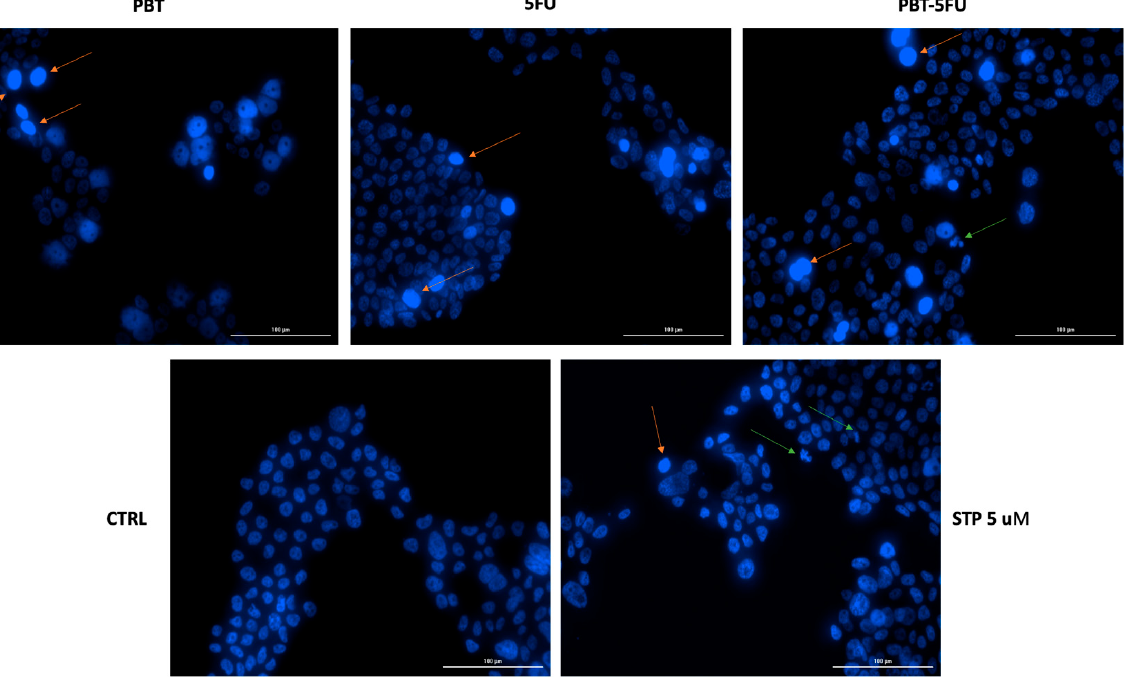
Figure 4. Hoechst 33342 staining of HT-29 cells’ nuclei following the 24 h treatment with: PBT, 5FU, and PBT-5FU. The orange and green arrows indicate nuclei expressing abnormal features. The scale bars represent 100 µm.